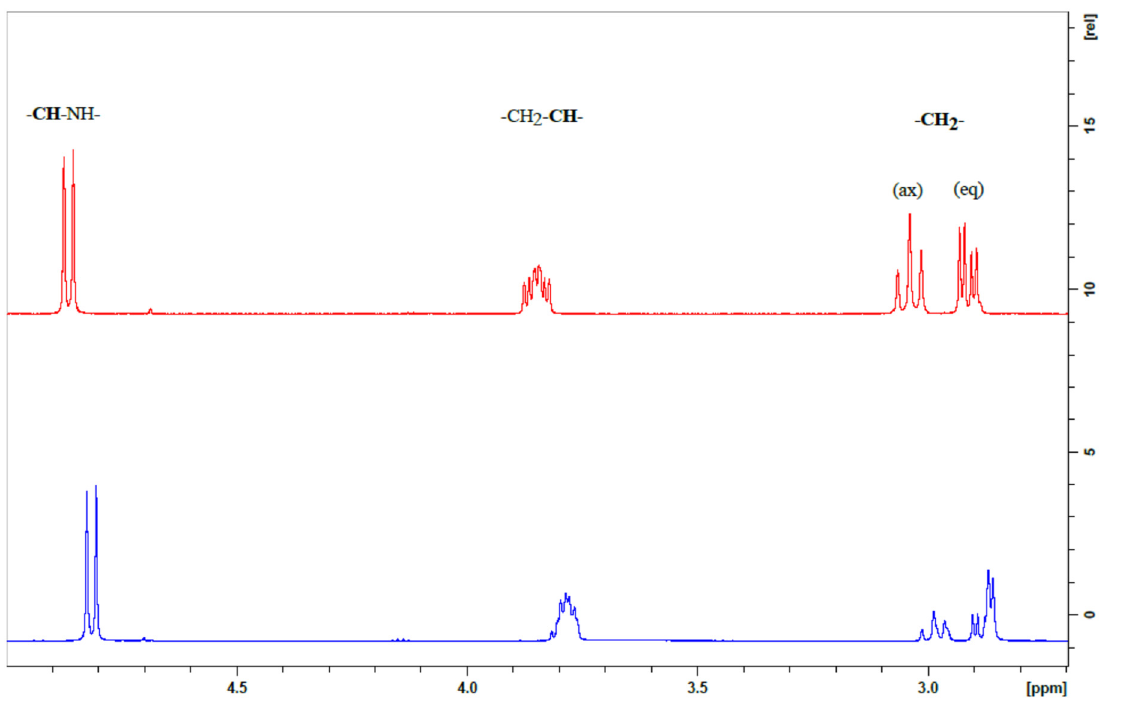
Figure 2. The aliphatic protons region of the 1 H NMR spectra of 6 (top) and partly deuterated 6 (bottom).